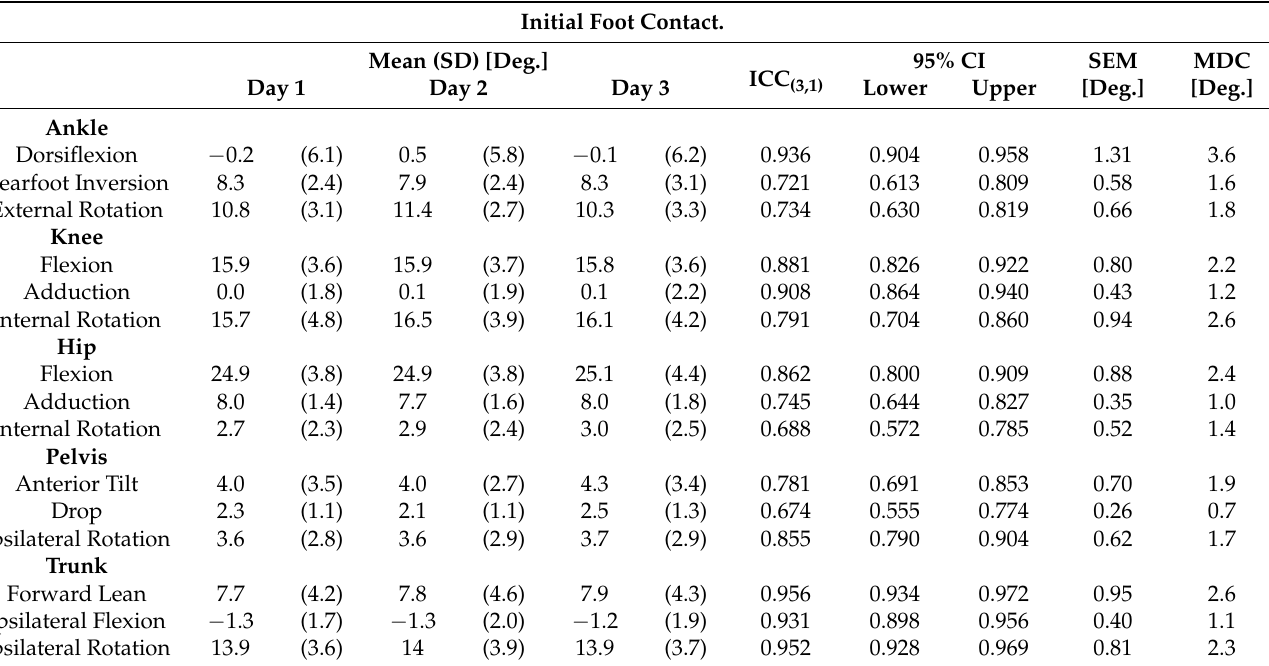
Table 3. Reliability of key kinematic metrics at initial foot contact across three distinct sessions and three distinct speeds in 21 runners.